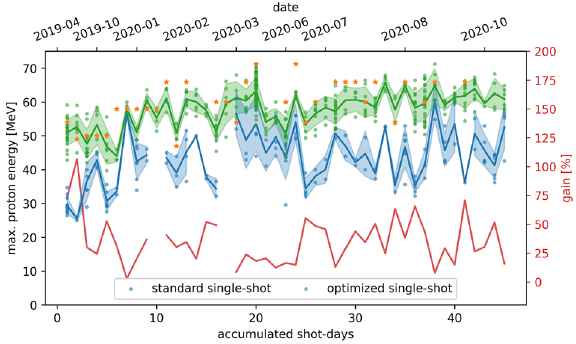
Figure 5. Long-term stability of the pulse shape optimization induced enhancement effect over a period of more than one year of operation for a total of 575 shots on 45 days of laser proton acceleration experiments. The laser target configuration was the same or very similar to the one described in the text (18 J pulse energy, plasma mirror cleaned contrast, oblique laser incidence, 200–400 nm thick Formvar targets). Compared are the performances obtained for standard (blue dots) and optimized spectral phase settings (green dots) represented by measured proton cut-off energies with TPS and complemented by RCF stack data (orange stars) whenever available. Each marker represents one single shot. The shaded area represents the standard deviation, the solid lines connect the mean of individual data sets serving as guide for the eye. The red solid curve indicates the performance gain in mean energy that was achieved by finding the optimized spectral phase